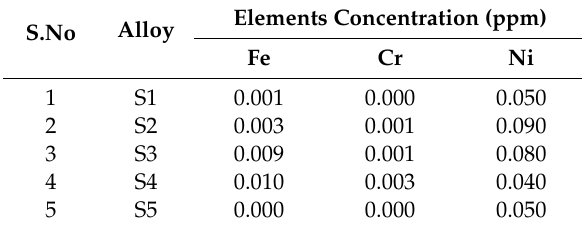
Table 5. Concentration of ions released in an artificial saliva